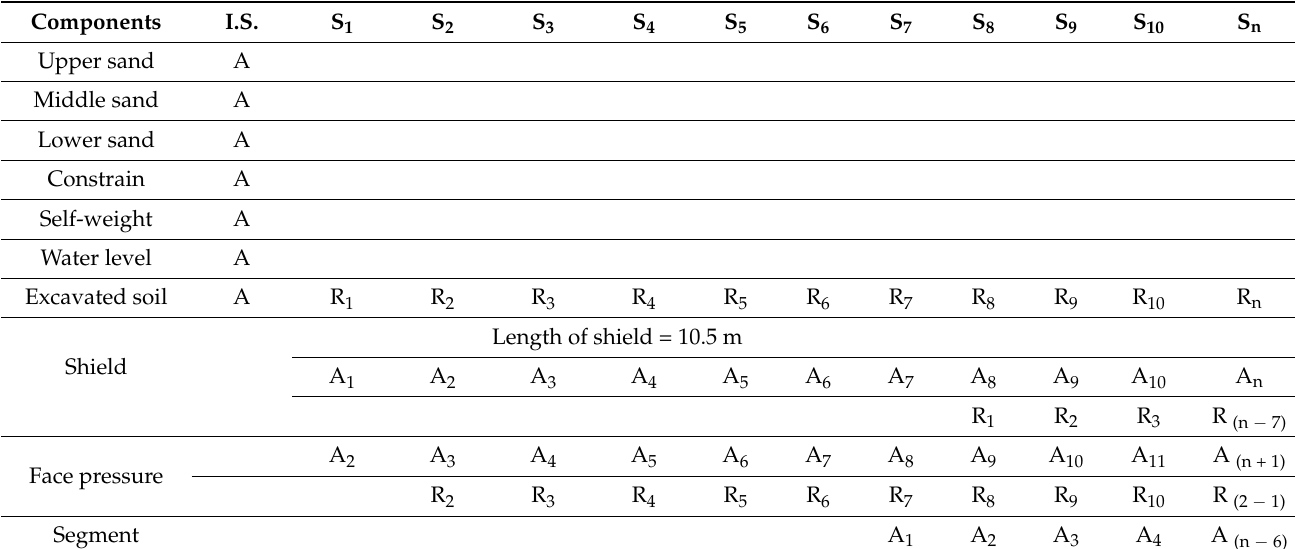
Table 6. Construction stages.